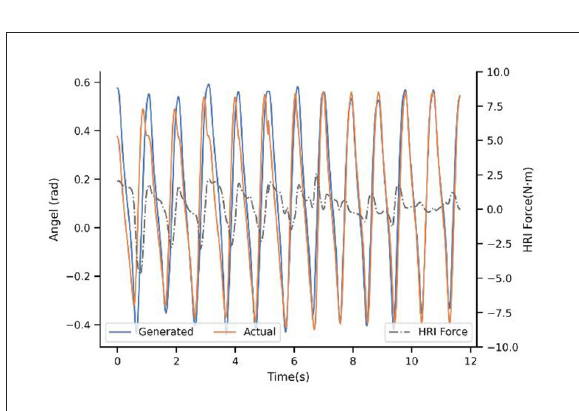
FIGURE8 Experimental result of subject 4 # with strategy PP-I.